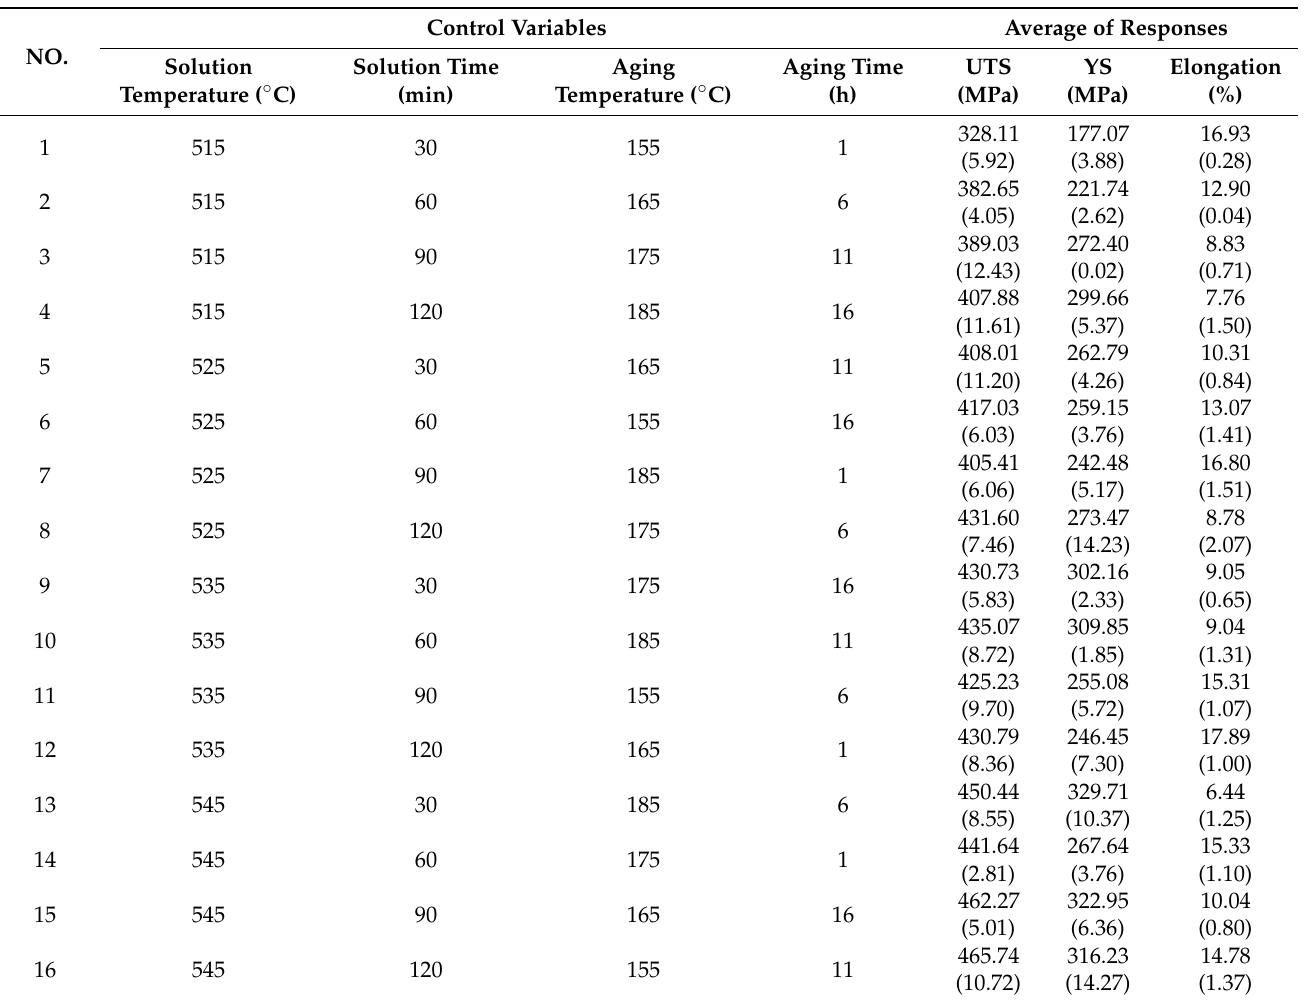
Table 3. L16 orthogonal array experiment design and responses.